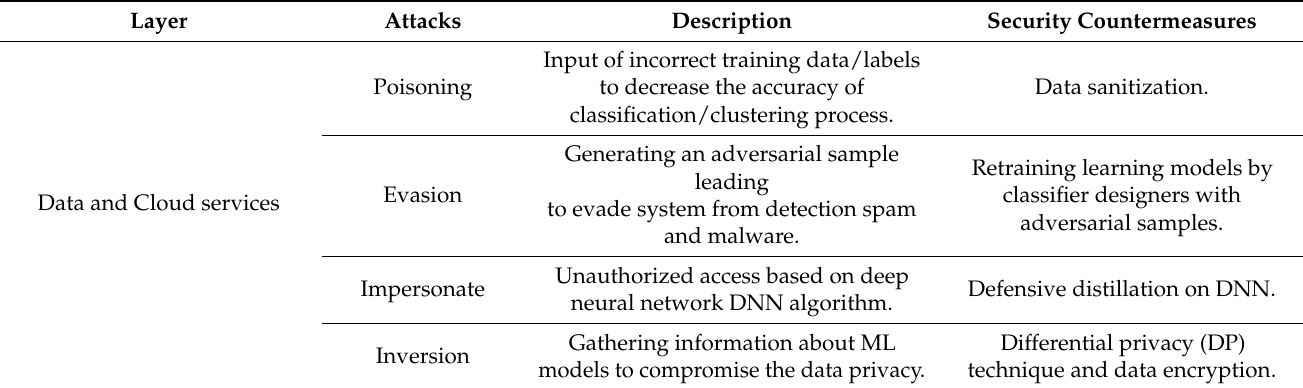
Table 7. The attack and countermeasures on data communication